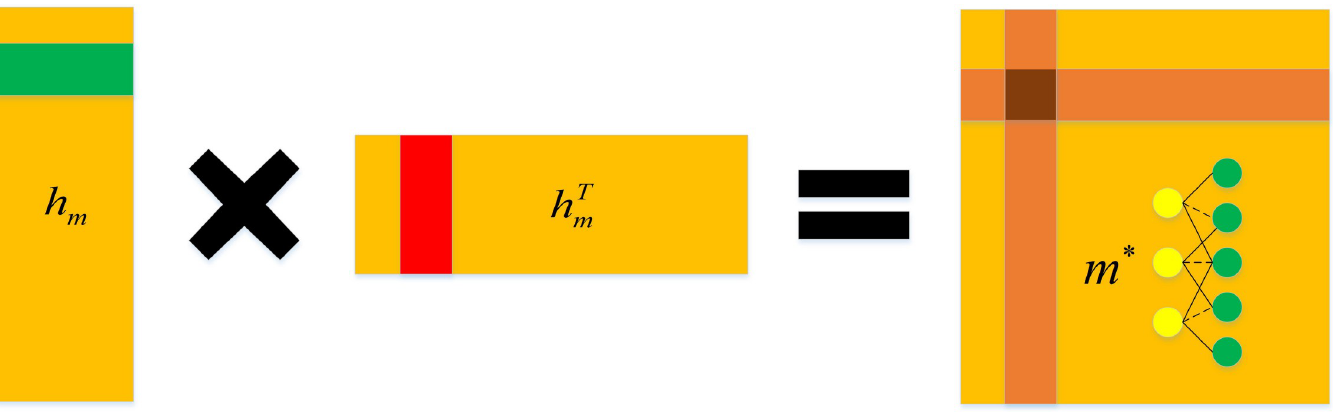
PLOS Computational Biology | https://doi.org/10.1371/journal.pcbi.1009655 December 10,